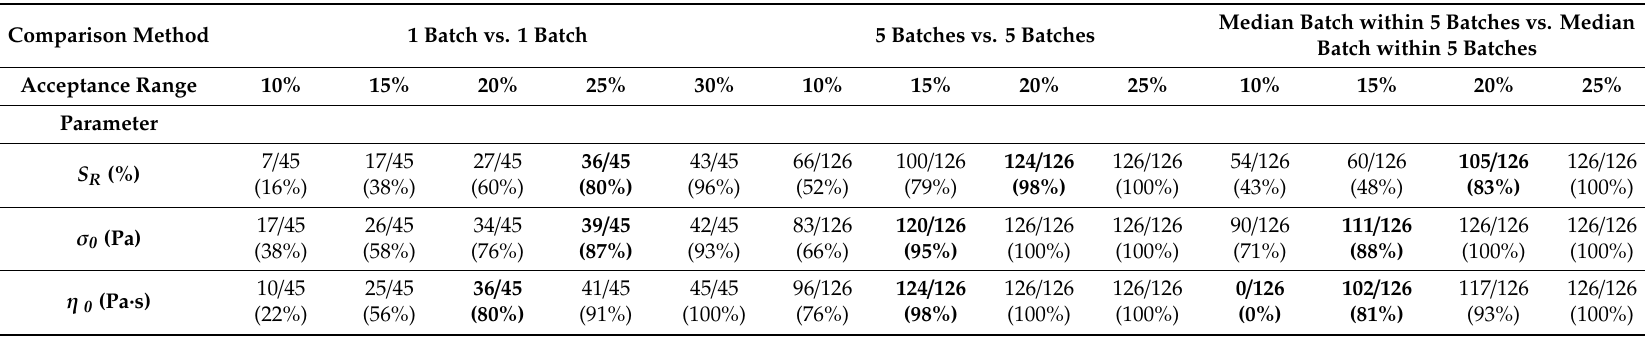
Table 2. Comparison of rheological parameters and spreadability. Number of ratios within the limits of equivalence ( n ) divided by total number of comparisons made ( N ). Comparison